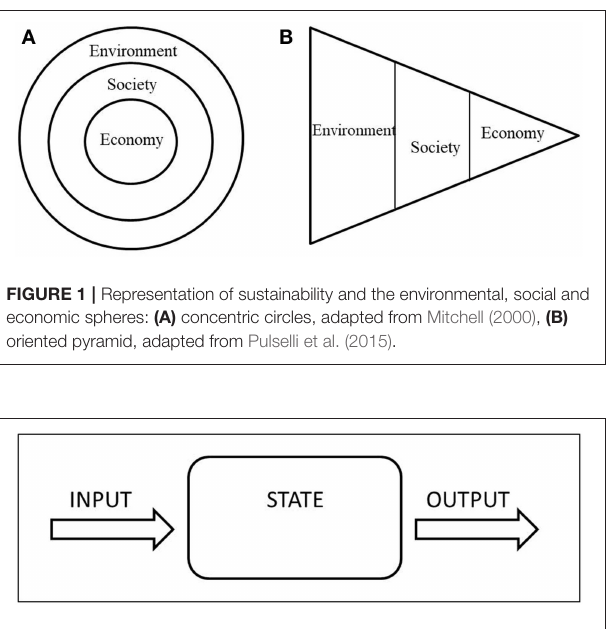
FIGURE 2 | The I-S-O